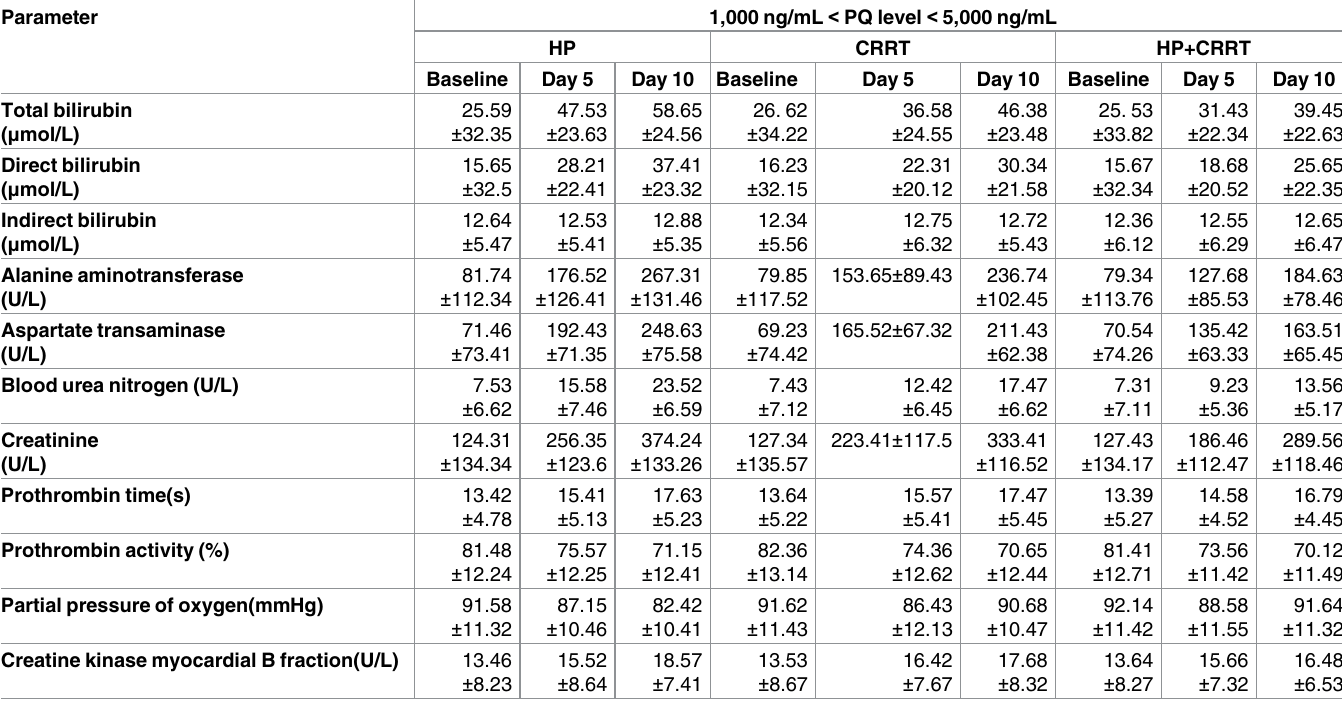
Table 3. Blood biochemical parameters of patients with high plasma paraquat (PQ) levels over time (n = 81).